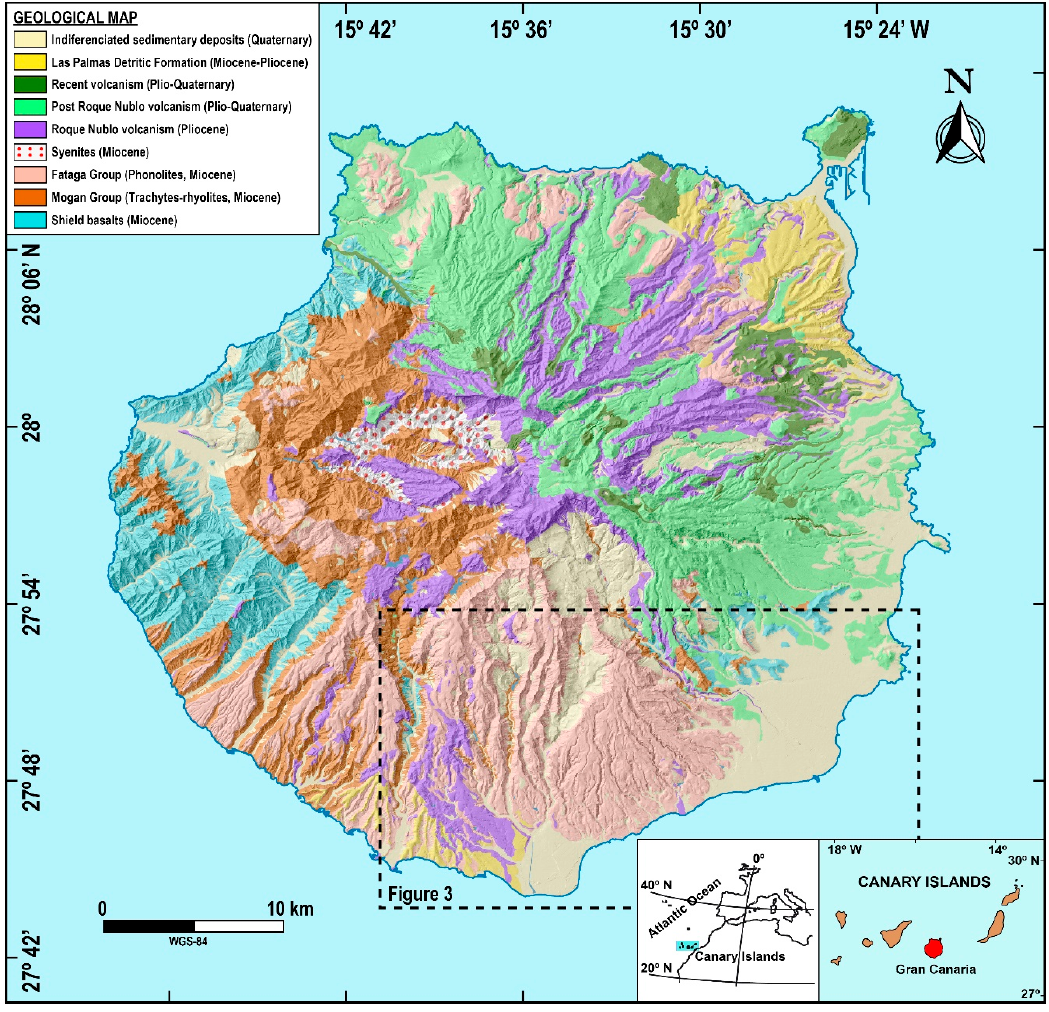
Figure 1. Geographical location of the Canary Islands’ Archipelago, and map of the Island of Gran Canaria, showing in detail the geological structure of the various areas of the island and the region under study.